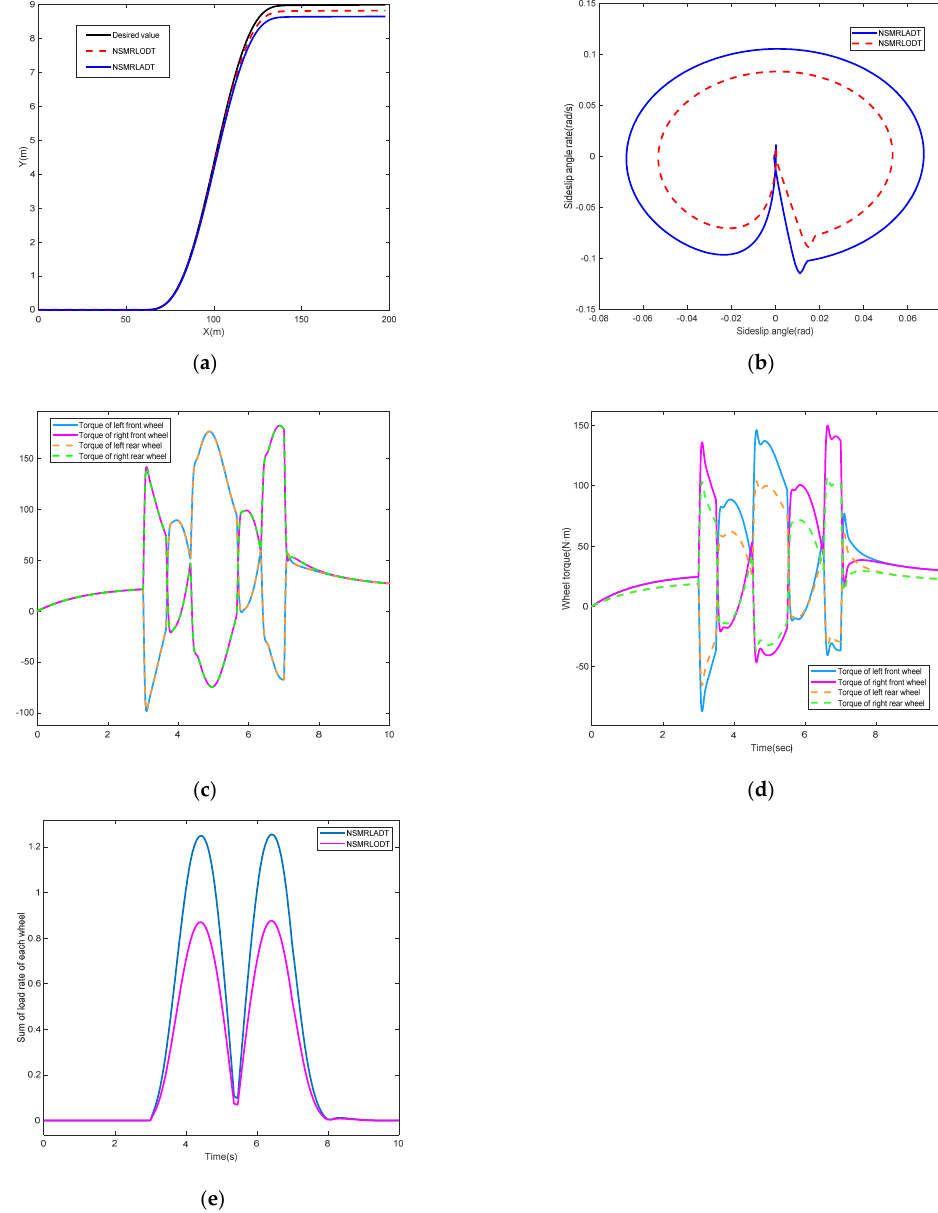
Figure 8. Front wheel steering angle under J-turn maneuver. The simulation results are shown in Figure 9, assuming driving at an initial speed of 80 km/h on a slippery road with an adhesion coefficient of 0.3.